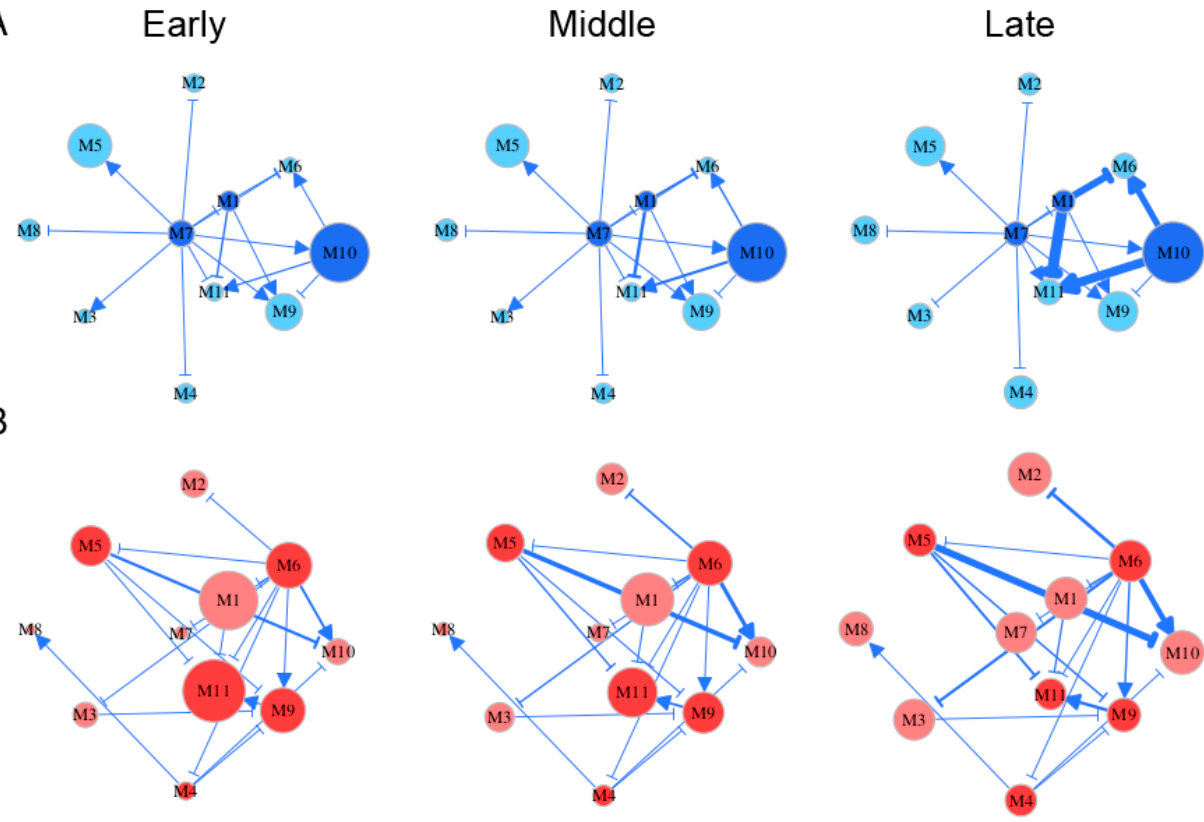
Figure 5. Stage-specific (early, middle, and late) gene networks among 11 modules, labeled M1–M11, for FGCs (blue) ( A ) and soma (red) ( B ). The size of circles is proportional to the mean expression level of all genes from a module. Arrowed lines and T-shaped lines denote the activation and inhibition of one module on the second, respectively. Hub modules in FGC and soma networks are highlighted in dark blue and dark red, respectively.